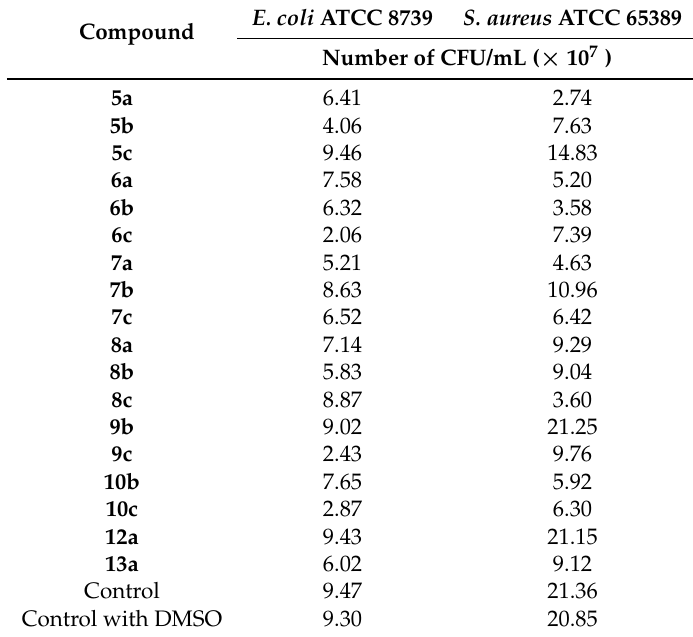
Table 3. The bactericidal activity of the investigated lactones against Escherichia coli ATCC 8739 and Staphylococcus aureus ATCC